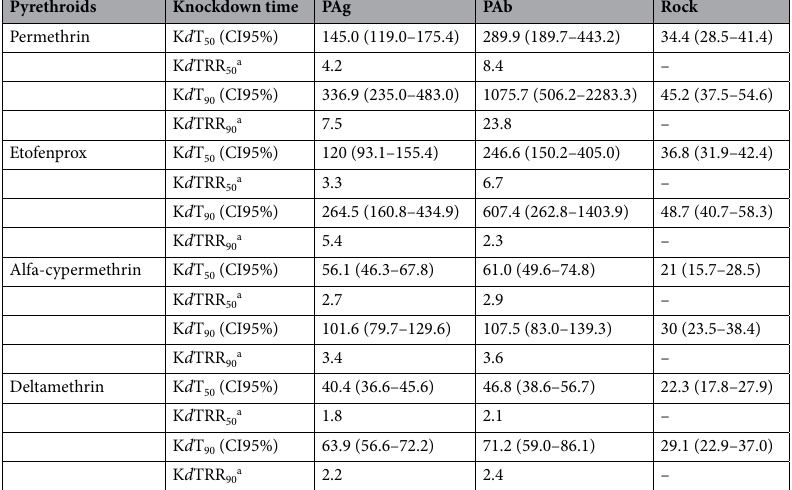
Pyrethroids Knockdown time PAg PAb